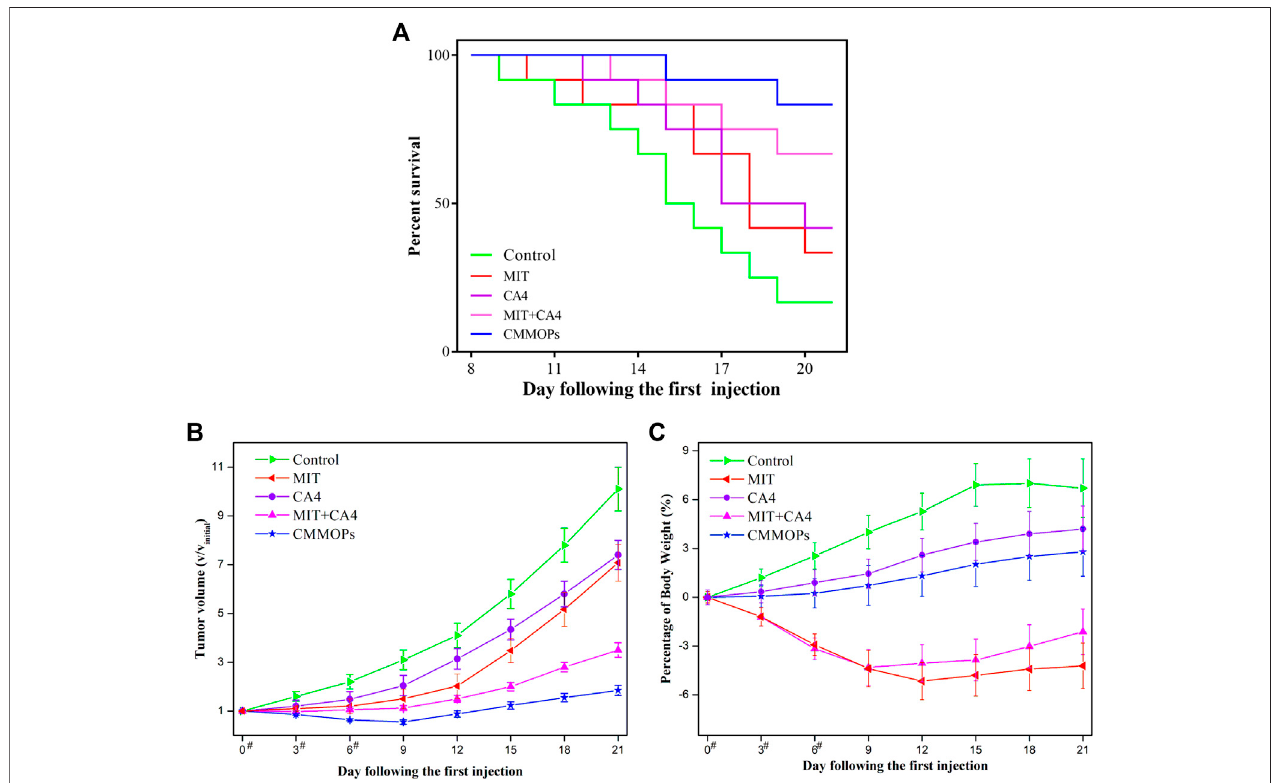
FIGURE5| Thesurvivalrate (A) ,tumorvolume (B) ,andbodyweightchange (C) ofthetumor-bearingmiceinjectedwithdifferentformulationsduringthetreatment ( “ # ” represents the day on which the intravenous administration was performed).